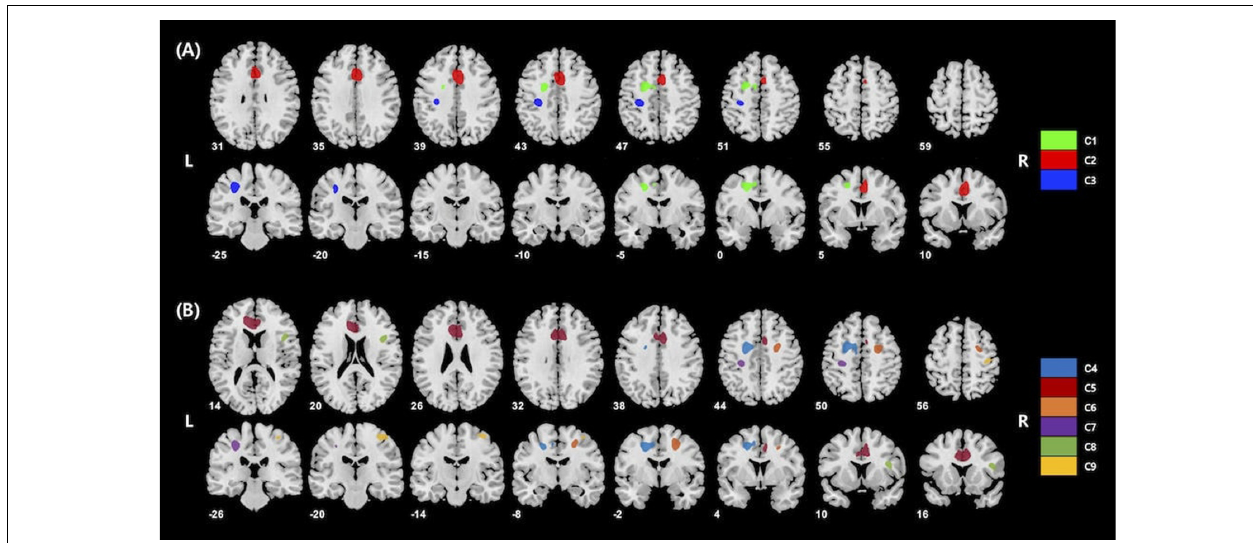
FIGURE 1 | (A) Results of whole-brain voxel-wise analysis presenting significant associations between cerebral glucose metabolism and korean adult reading test (KART)-estimated full-scale IQ (FSIQ) score in all cognitively normal (CN) subjects. Positive correlations were shown in the left middle frontal gyrus (MFG), right anterior cingulate gyrus (ACG) and left postcentral gyrus (PCG). Cluster numbers (e.g., C1) correspond to those in Table 2 . (B) Results of whole-brain voxel-wise analysis presenting significant associations between cerebral glucose metabolism and KART-estimated FSIQ score in amyloid- β (A β )-negative CN subjects. Positive correlations were shown in the bilateral middle frontal gyri, bilateral anterior cingulate gyri, bilateral postcentral gyri and right inferior frontal gyrus (IFG). Cluster numbers correspond to those in Table 3 .